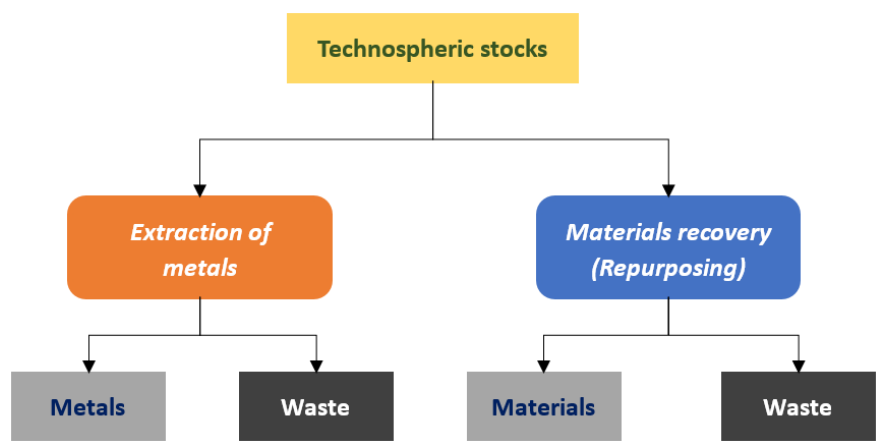
Figure 2. Metal and material recovery flow of technospheric stocks.